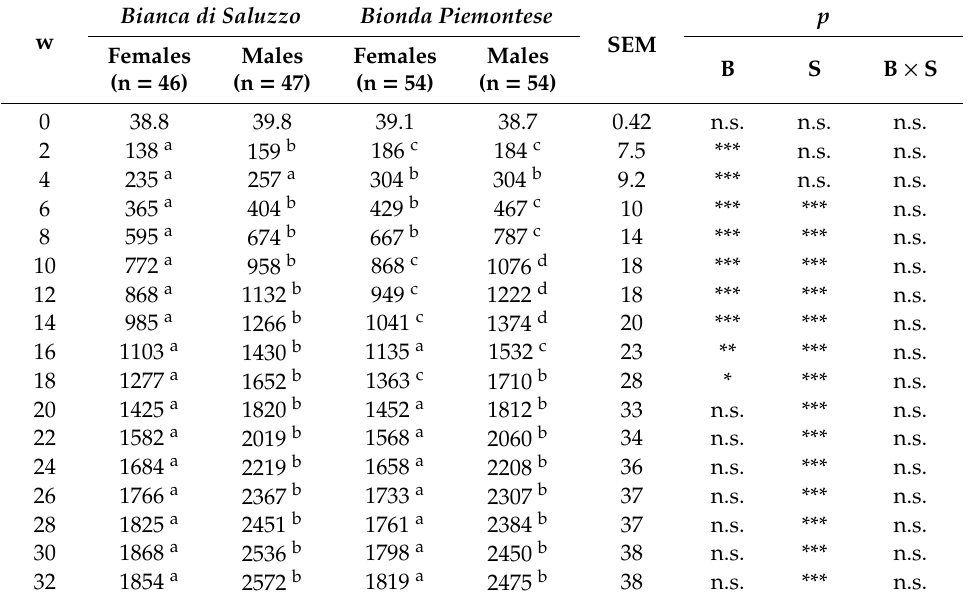
Table 1. Average actual body weight (g) of the males and females of the Bianca di Saluzzo and Bionda Piemontese chickens during the growing